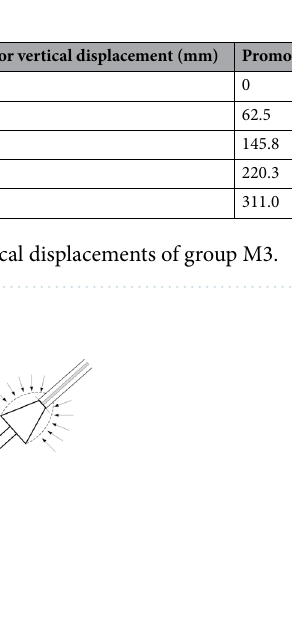
Figure 20. Anti-uplift mechanism of multibell anchor pulling out failure.